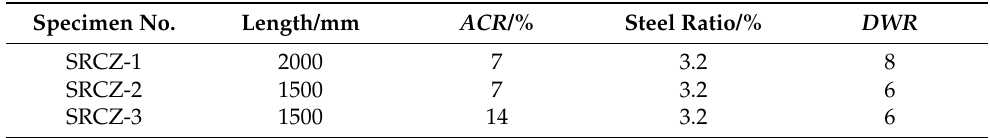
Table 1. The Design Parameters for the Test Specimens. Specimen